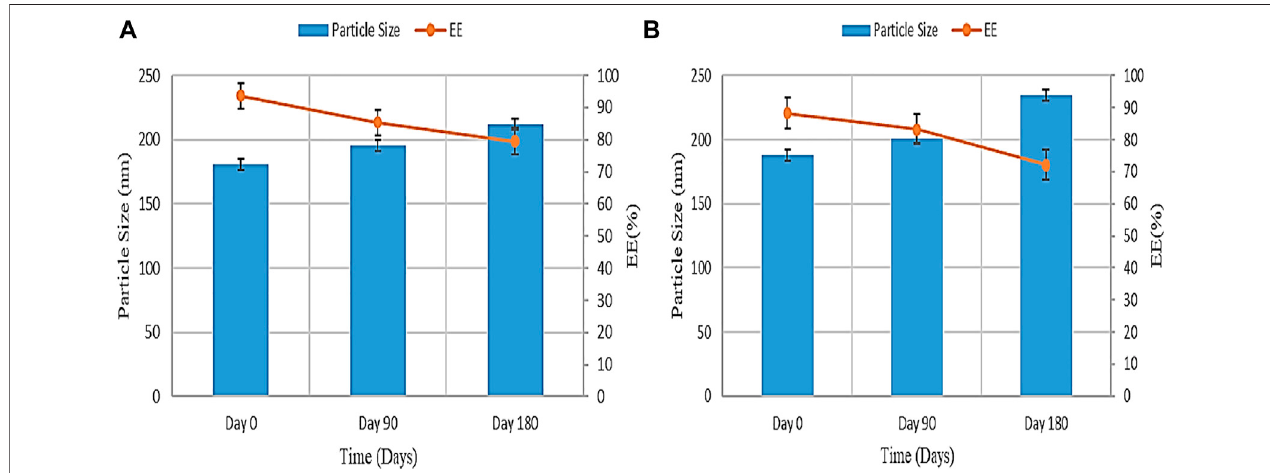
FIGURE 7 | Stability study of PGZ-NLCs (A) at 25 ° C and (B) 40 ° C.